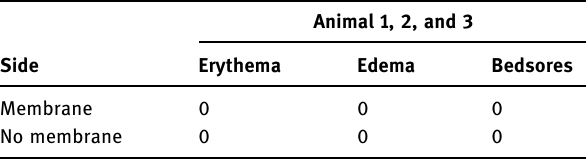
Table 4: Intracutaneous test results